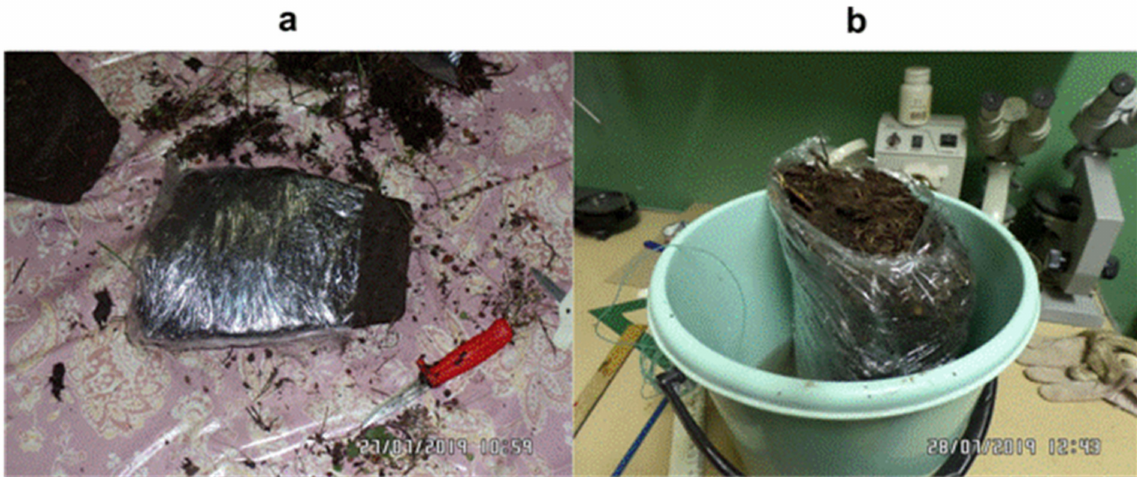
Figure 10. Procedure for preparing undisturbed samples for laboratory experiments: ( a ) packing in film and ( b ) placing the sample into a